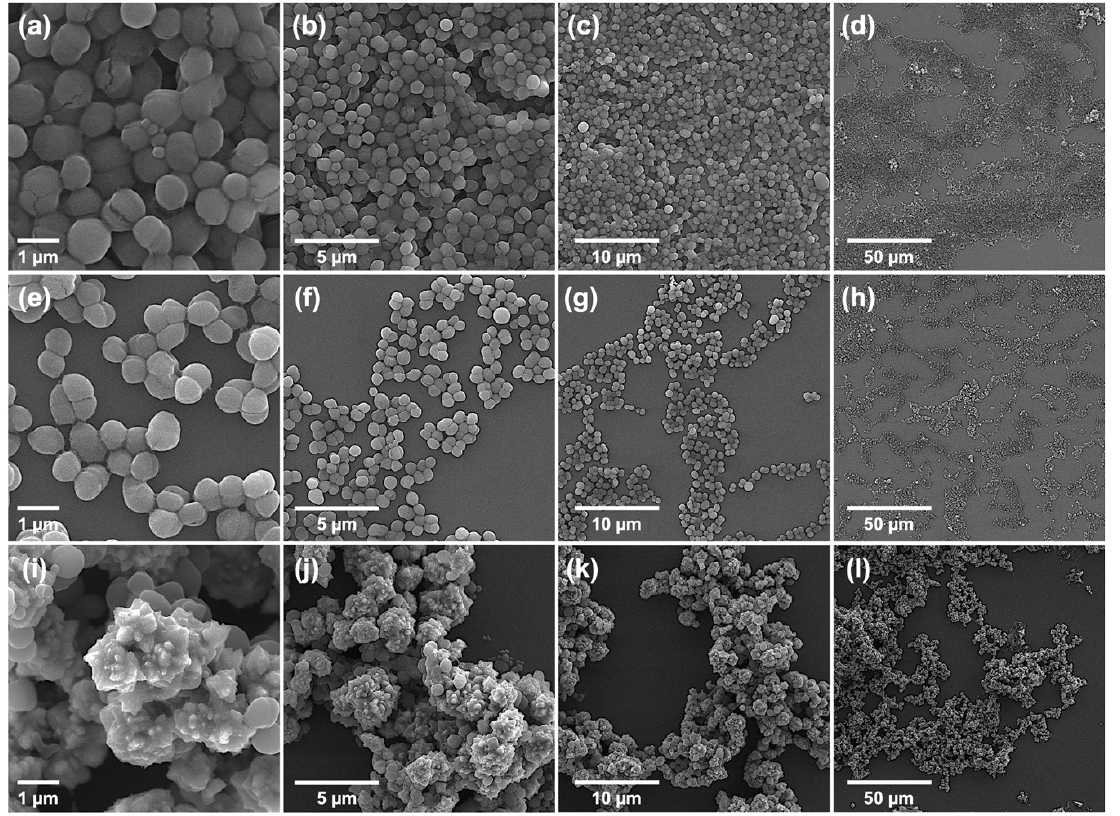
Figure 5. Cell morphology analysis. Scanning electron microscopy (SEM) images of MDR S. epidermidis cells of ATCC 12228 without ( a – d ) treatment with either 1/4 MIC ( e – h ) or 1/2 MIC ( i – l ) of TZ NC, respectively were shown. No membrane disruption was shown in 1/4 MIC of TZ NC treated cells ( e – h ) compared to non-treated cells. The whole membrane was aggregated with TZ NC in cells treated with 1/2 MIC of TZ NC ( i – l ), inducing partial membrane rupture.